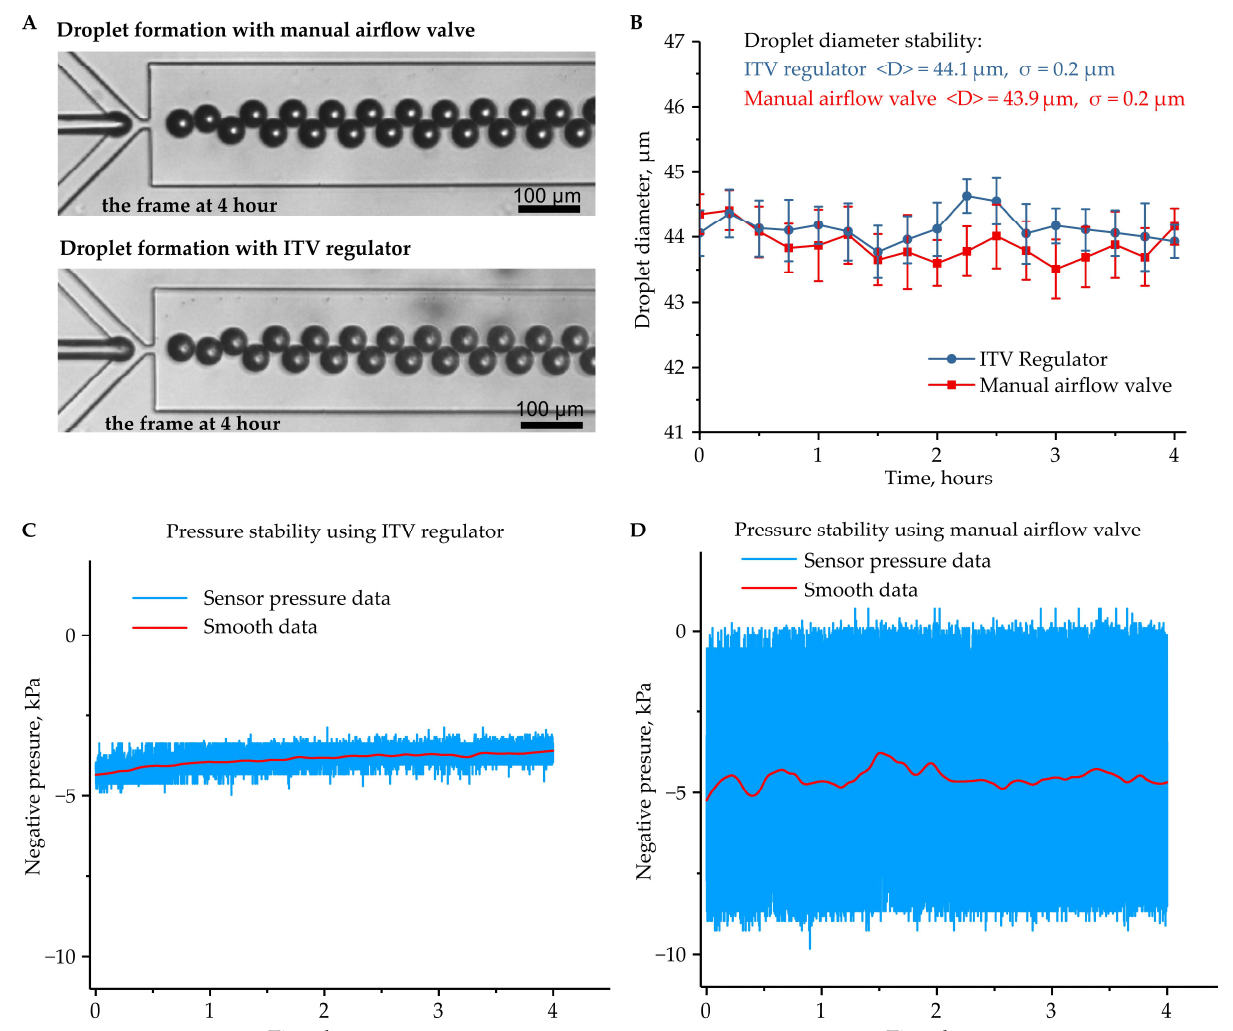
Figure 2. Stability of the droplet generation regimes. ( A ) Images of droplet generation in the microfluidics device using an ITV regulator and a manual airflow control valve; ( B ) droplet diameters during the 4 h stability test. Error bars indicate standard deviation. Pressure in the outlet reservoir was measured by an external pressure sensor during the 4 h stability test in the setup with the ITV regulator ( C ) and the manual airflow control valve ( D ). The experimental data were smoothed by Loess regression (span = 0.1).